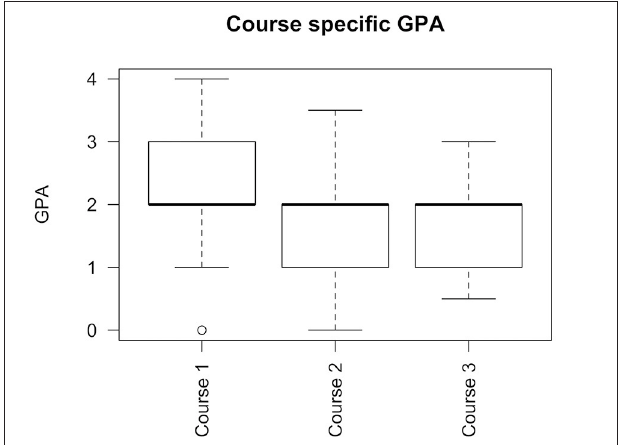
FIGURE 1 | Course specific GPA. Boxplot showing median, 1st and 3rd quartile and 95% CI. A median GPA of 2 for all courses was observed.